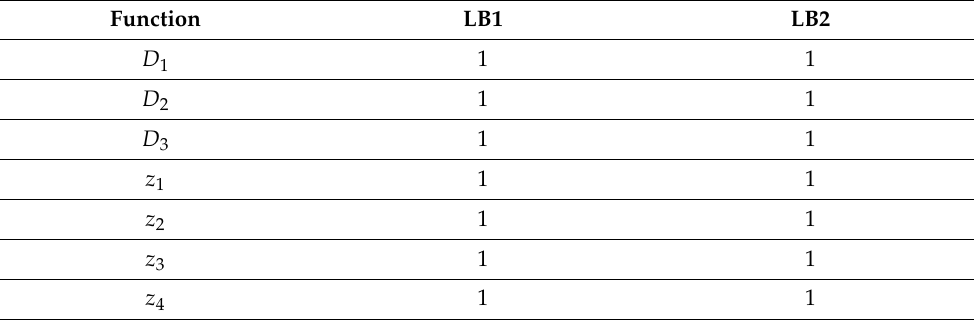
Table 5. Table of LTZ.